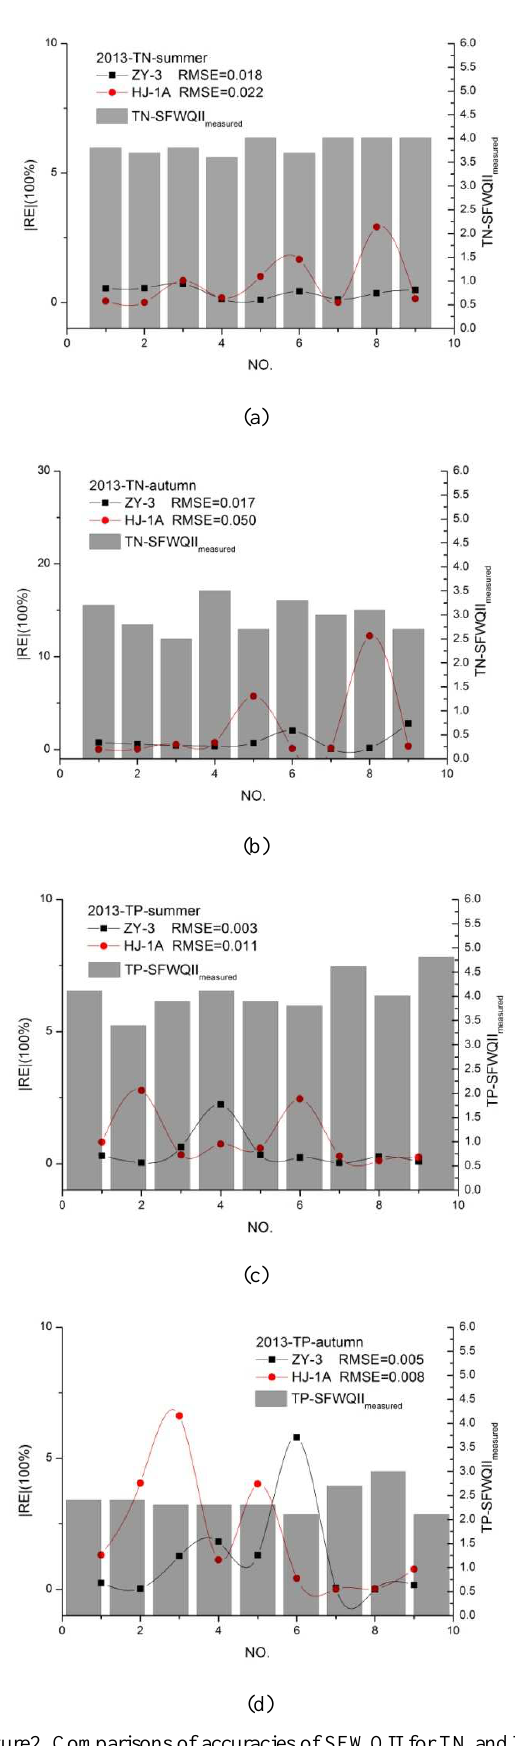
Figure2. Comparisons of accuracies of SFWQII for TN and